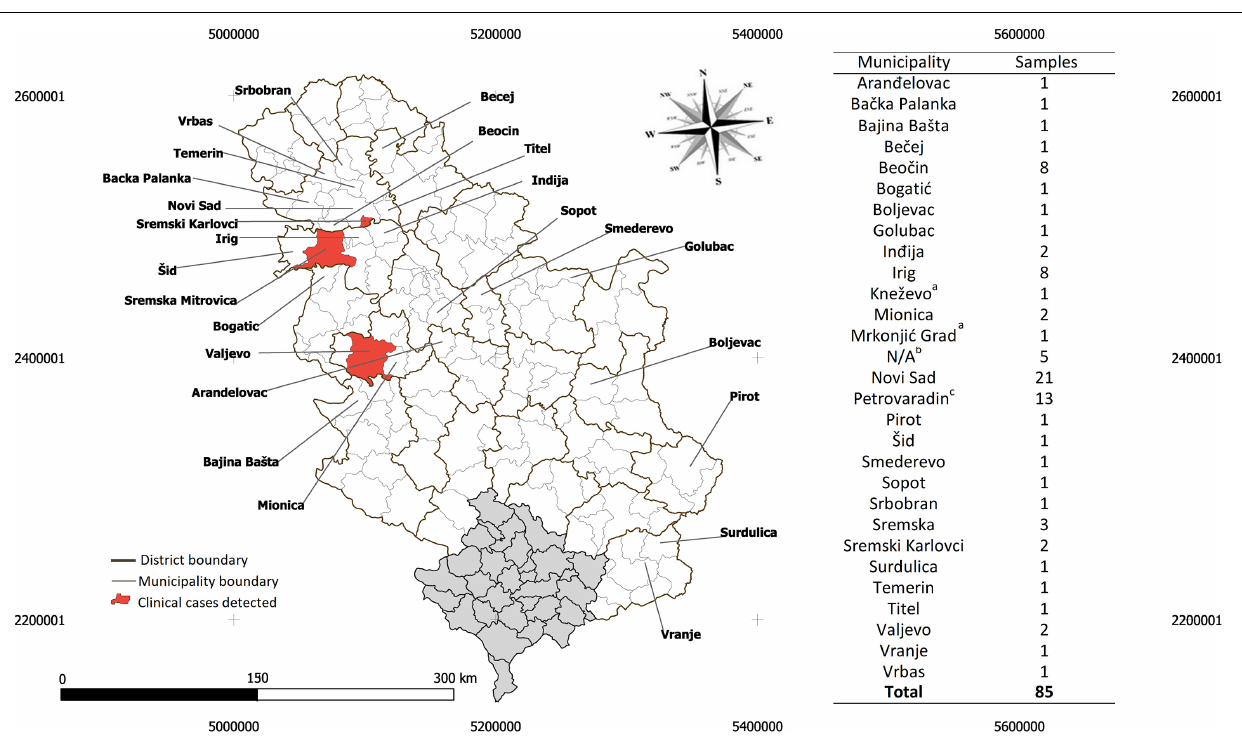
FIGURE 1 | Geographical location of the patients infested by ticks in Serbia and enrolled in the study. The sample distribution is presented by municipalities, across the districts of Serbia ( Supplementary Table 1 ). (‘a’) Two case studies from two municipalities in the neighboring country, Bosnia-Herzegovina, were labeled. (‘b’) Patients from Fruška Gora mountain with no specific municipality were labeled N/A. (‘c’) Petrovaradin is a small municipality adjacent to Novi Sad. The Serbian and Kosovo shapefile for mapping at district and municipality levels is available at the GADM database of Global Administrative Areas (v3.6, April 2020, https://gadm.org/). The map was generated using QGIS v3.12 (QGIS Development Team